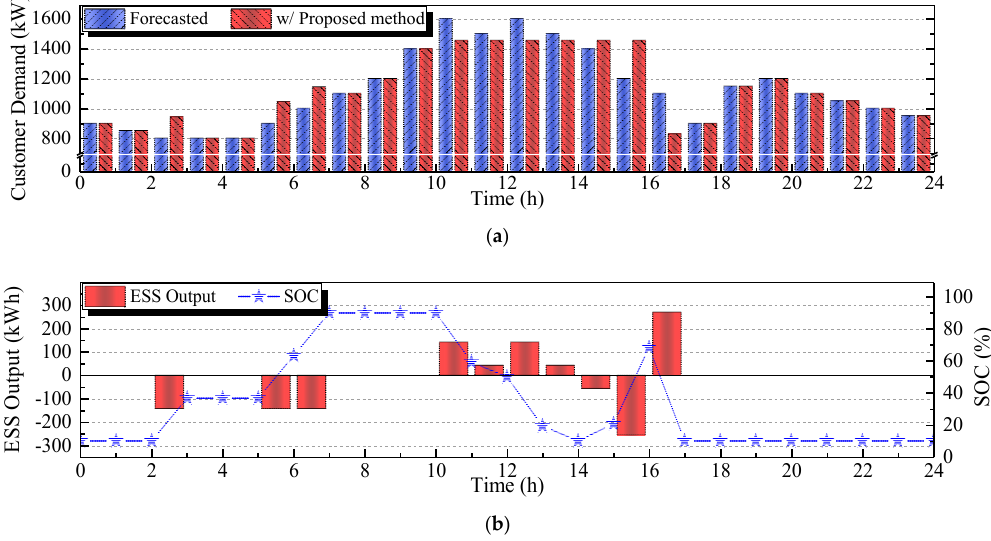
Figure 7. Results of the case study without considering the Ontario peak contribution cost (OPCC): ( a ) Customer demand; ( b ) Scheduled output and SOC of the